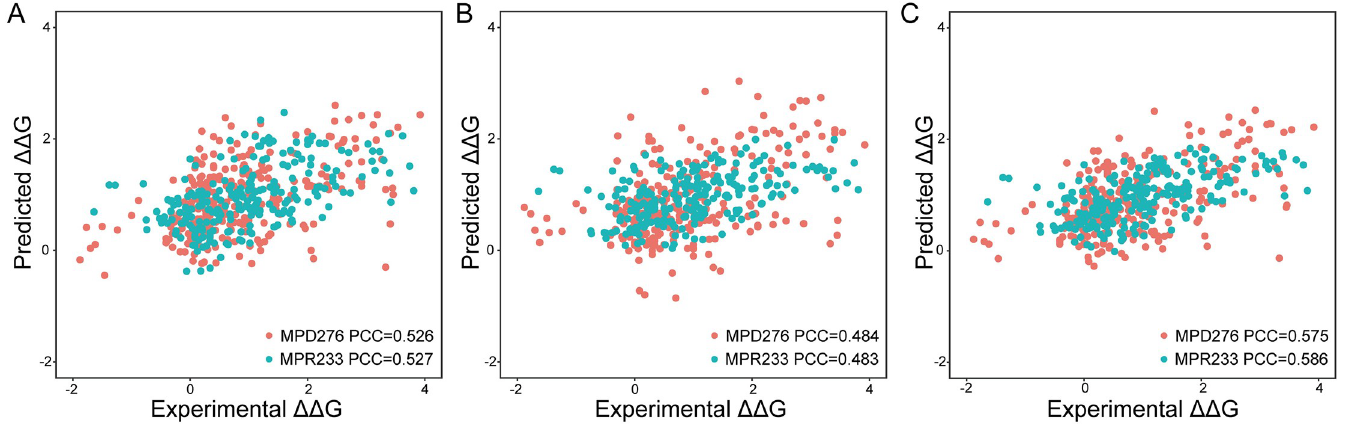
Fig 4. PCC values of different models for LOCOV. (A) Energy feature-based model. (B) Nonenergy feature-based model. (C) Integrative model (PEMPNI).